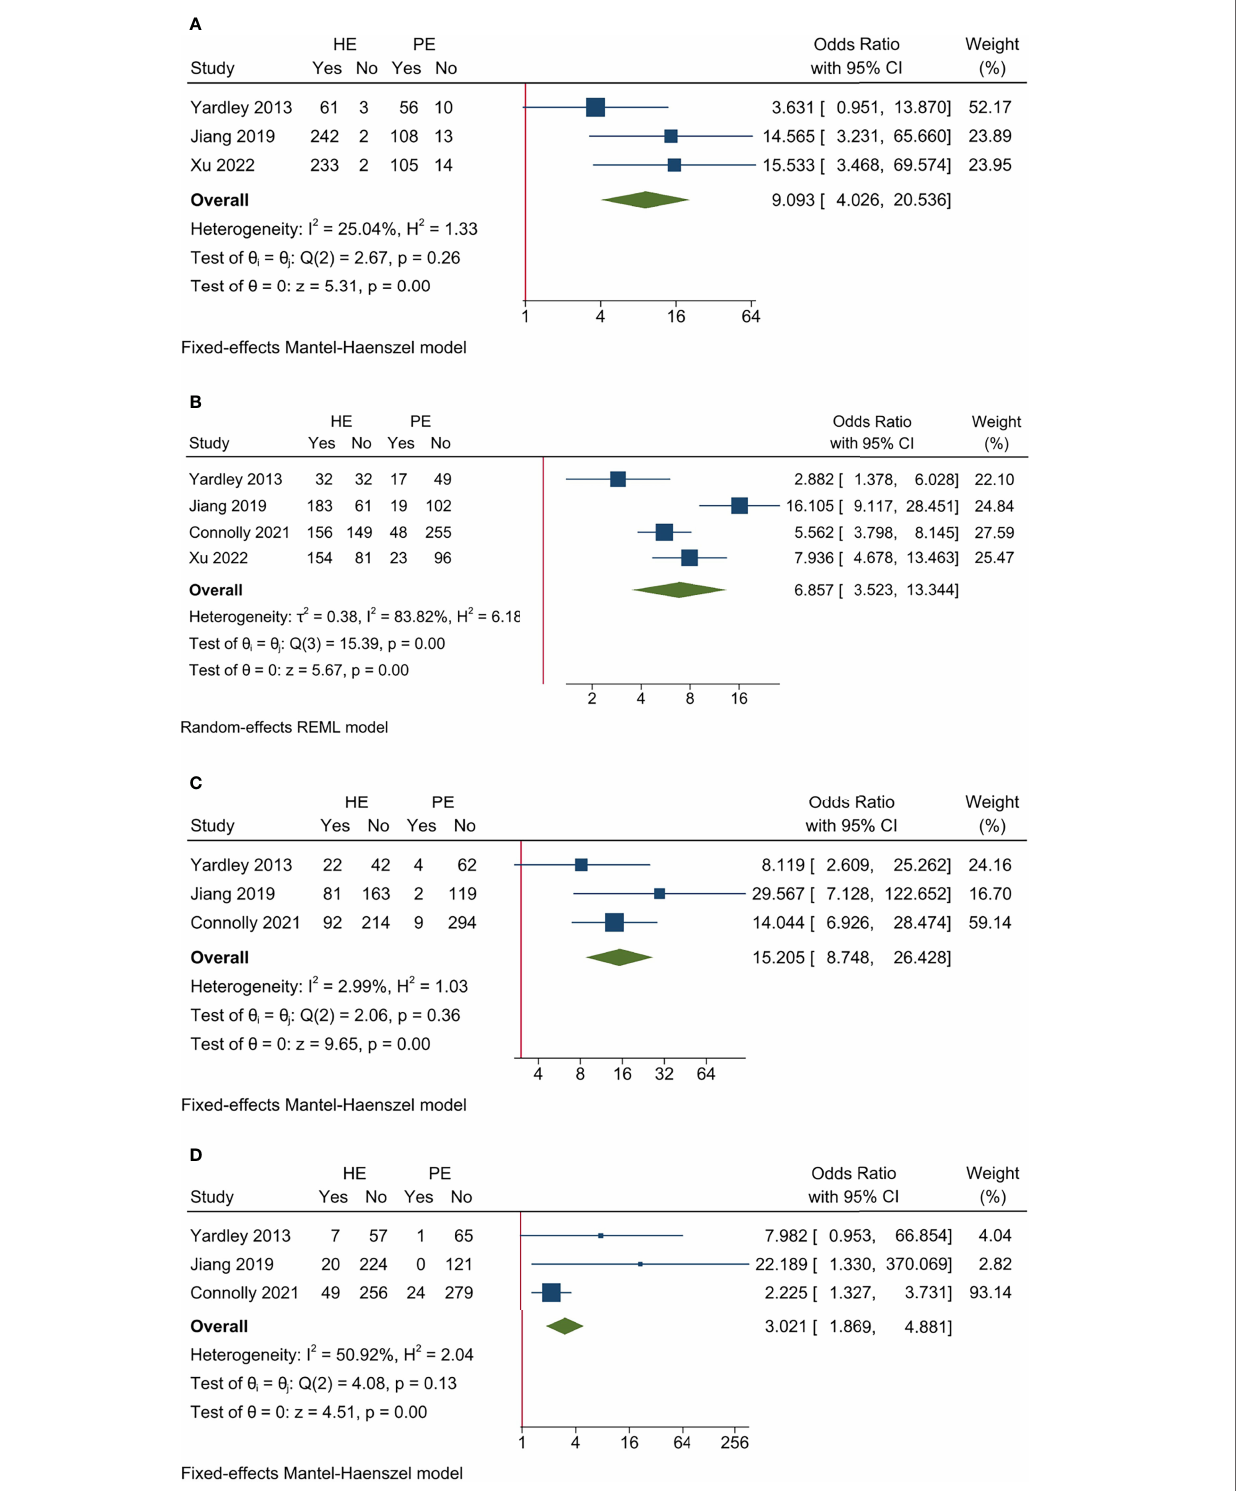
FIGURE 3 | Pooled results for AE endpoints of included studies. (A) All AE; (B) Grade ≥ 3 AE; (C) dose modi fi cation due to AE; (D) treatment discontinuation due to